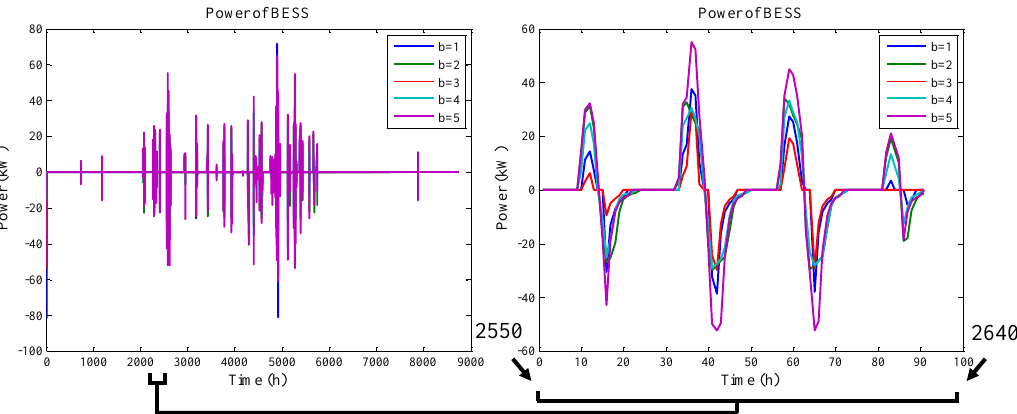
Figure 21. Battery power time series.